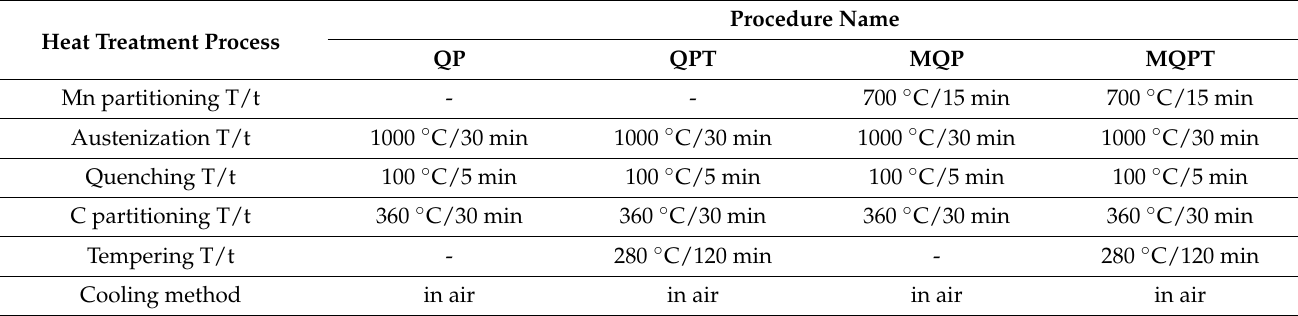
Table 1. Heat treatment schedules of the